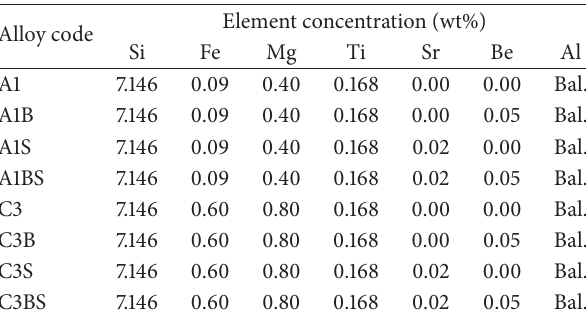
Table 1: Average chemical composition (wt%) of the 356 and 357 alloys